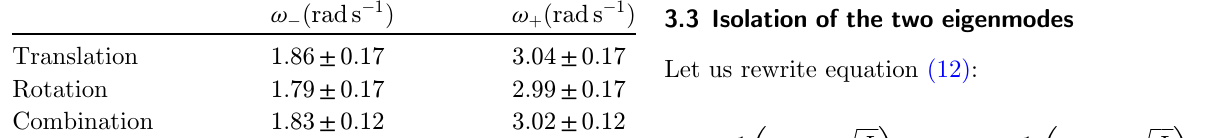
obtained with the spectral +